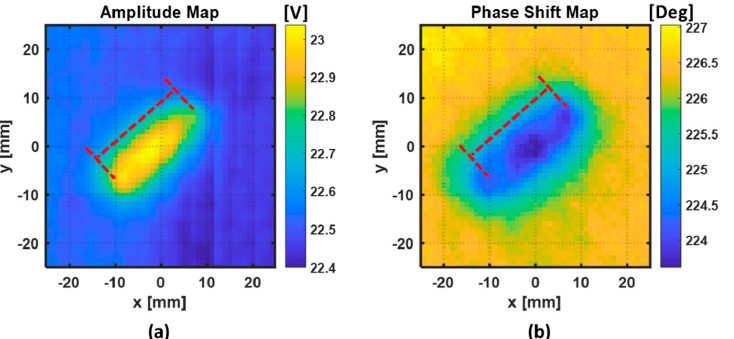
Sensors 2022 , 22 , x FOR PEER REVIEW Figure 13. Representation of the C-scan performed in the vicinity of the estimated position of the fiber break, using ECT Configuration 1: ( a ) amplitude perturbations; ( b ) phase shift perturbations.